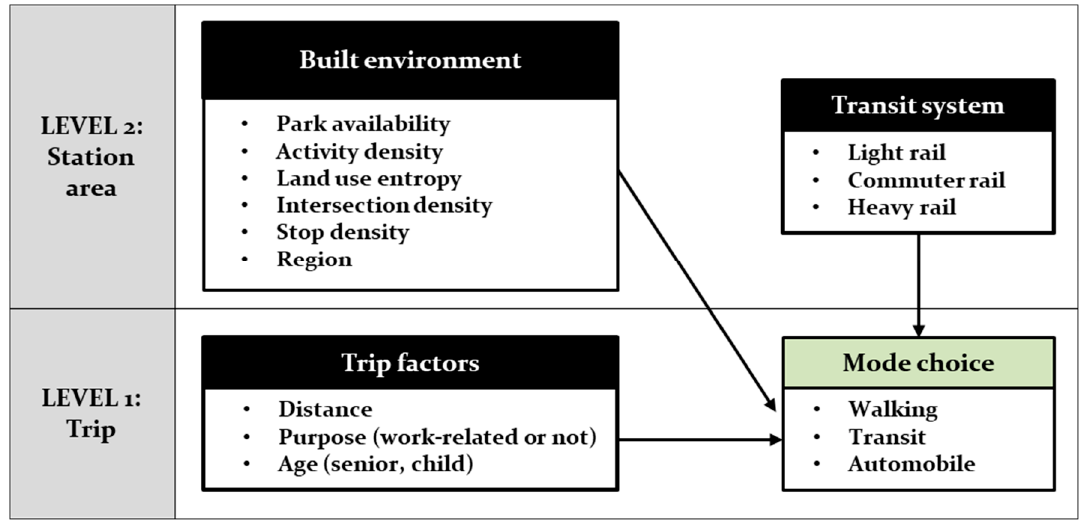
Figure 2. Multilevel model of mode choice in station areas.